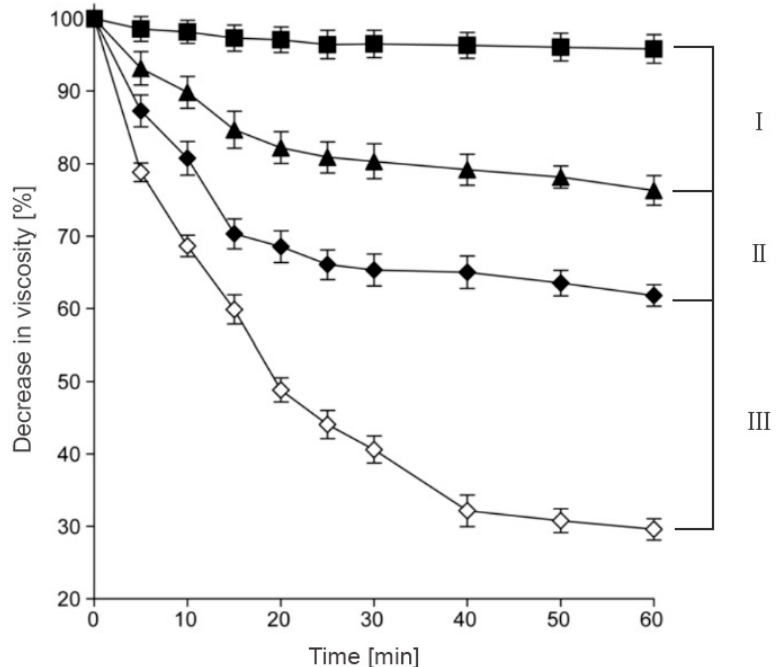
Figure 4. Decrease in viscosity of HA and HA-Cys by hyaluronidase (0.5 mg/mL) at pH 6.0; HA without hyaluronidase ( ■ ), HA-Cys (crosslinked) ( ▲ ), HA-Cys ( ♦ ) and HA ( ◊ ). Indicated values are means of at least three experiments (±SD); I and II differ from III, p < 0.00001; I, differs from II, p < 0.0006. Adapted from Kafedjiiski [14].